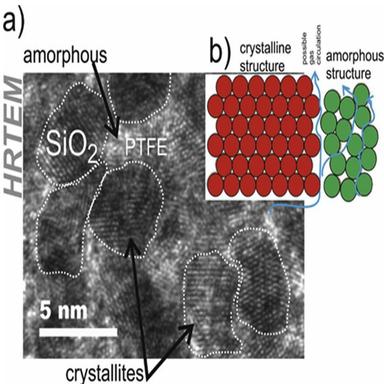
Magnified HRTEM image from the PTFE + SiO2 layer showing the possibility for gas circulation through the amorphous structure: a). the original HRTEM image of the SiO2 nano-crystallites in the PTFE amorphous structure and b). schematic of the crystalline structure- amorphous structure interface and possible gas circulation.